Question: Give a one-sentence summary of this figure.
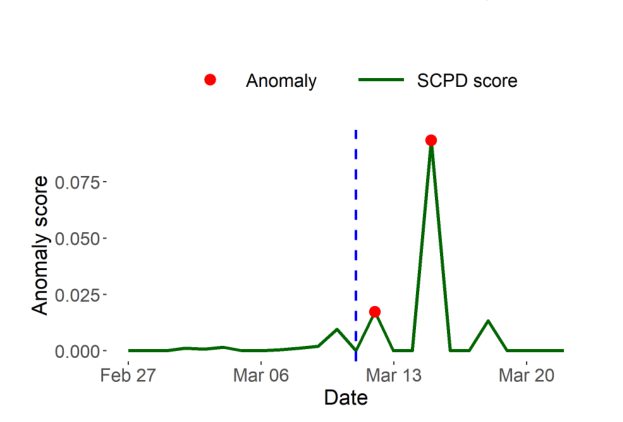
Answer: USDC anomalous days identified by SCPD . Compared to decay and expansion measures by InnerCore, SCPD less accurately captures USDC’s temporary peg loss occurring on Mar 11, 2023.